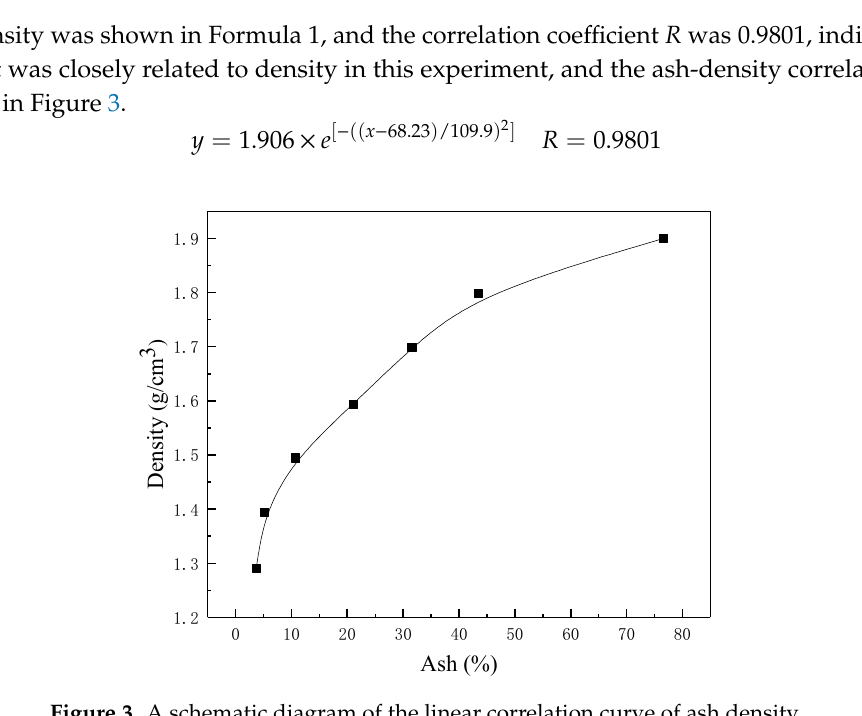
Figure 3. A schematic diagram of the linear correlation curve of ash density.